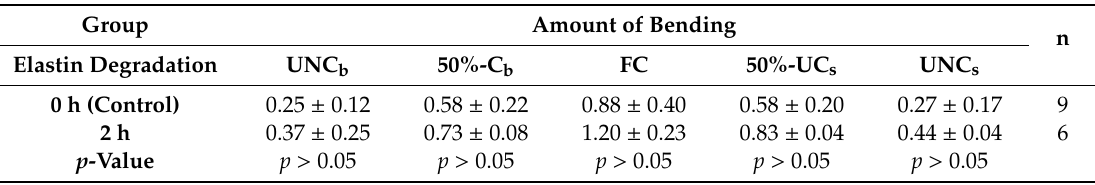
Table 4. Mean ± SEM of bending of samples of max curvature, k max (1 / mm) at five levels of bending for the un-degraded and elastin-degraded porcine aortic valve leaflet specimens after 2 h of elastase exposure (n = 6–9 samples / group). UNC b , 50%-C b , stands for unconstrained and semi-constrained